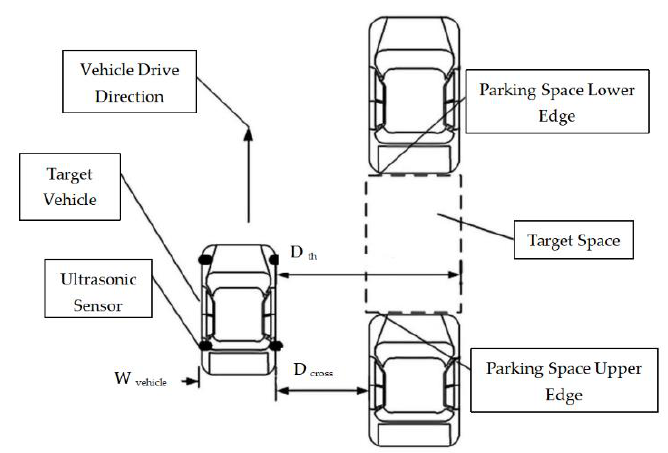
Figure 1. Mimic diagram of parallel parking spot.